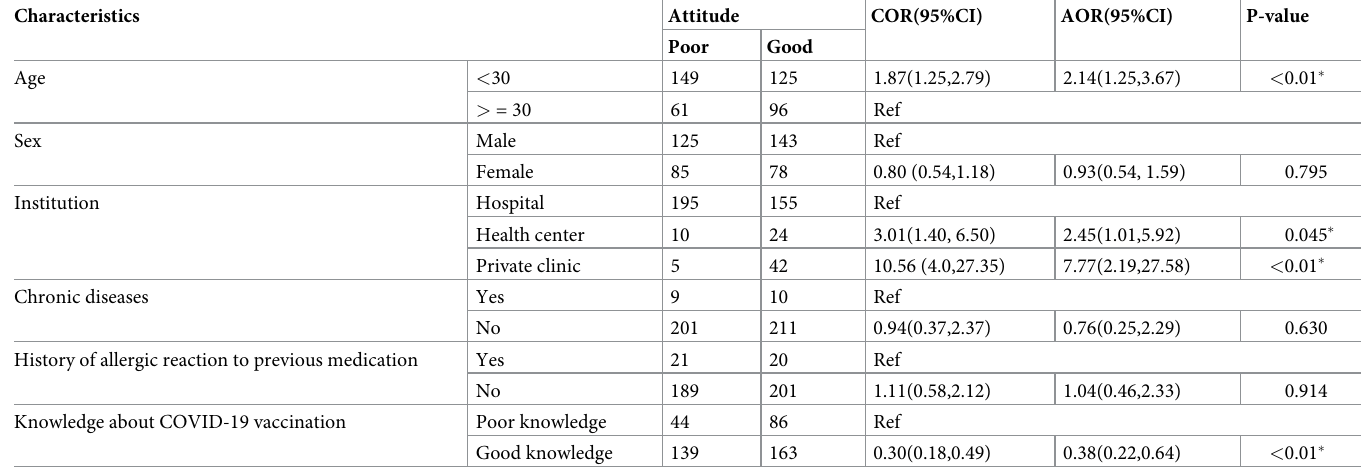
Table 4. Multivariable analysis of factors associated with attitude towards COVID-19 vaccine among health professionals in Nekemte city, Western Ethiopia.